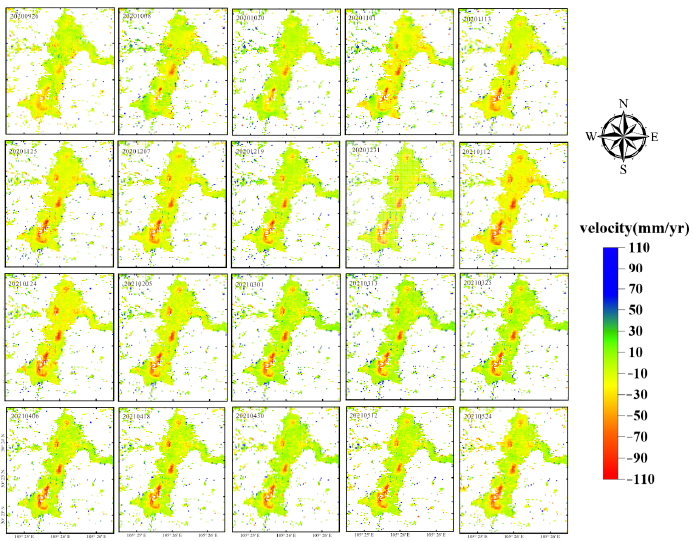
Figure 6. Subsidence characteristics of Anju Airport in time series from September 2020 to May 2021.